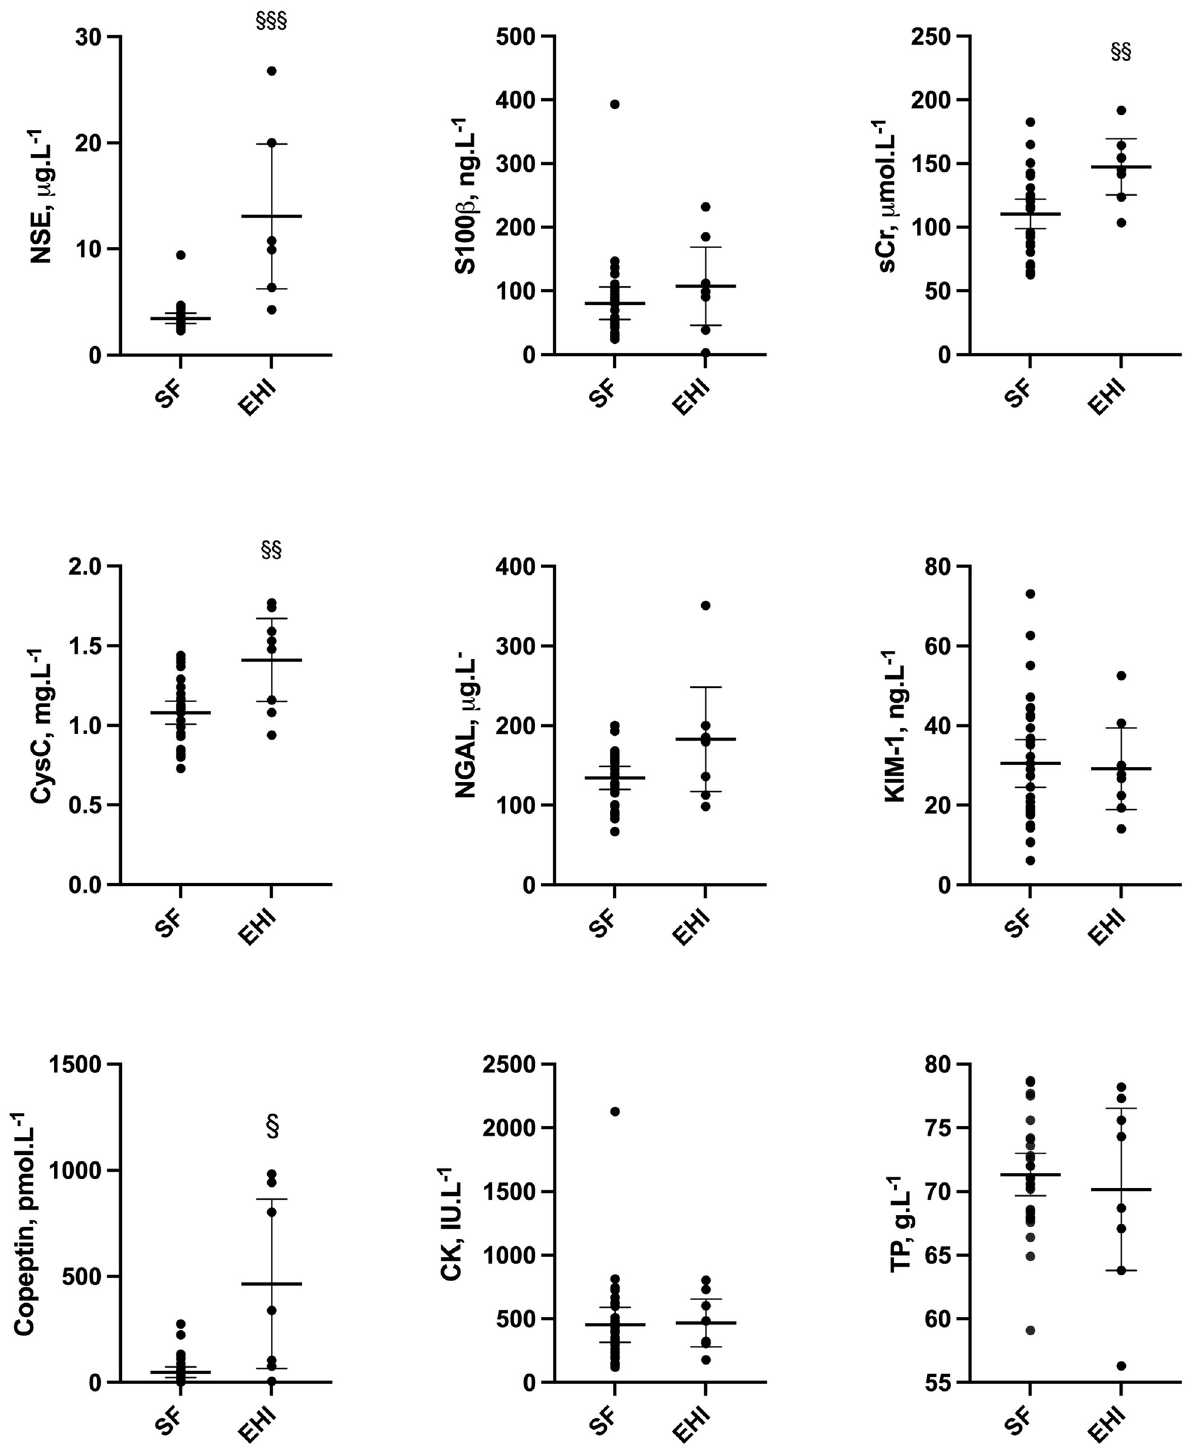
Fig 2. Biochemical comparison at T0 (marathon completion or withdrawal) for 30 successful finishers (SF) vs 8 Exertional Heat Illness cases (EHI) � §§§ P < 0.0005, §§ P < 0.005, § < 0.05. � n = 7 for copeptin. CK–creatine kinase; cysC–cystatin C; KIM-1 –Kidney Injury Molecule 1; NGAL– neutrophil gelatinase associated lipocalin; NSE–neuron specific enolase; sCr–serum creatinine; TP–Total protein .